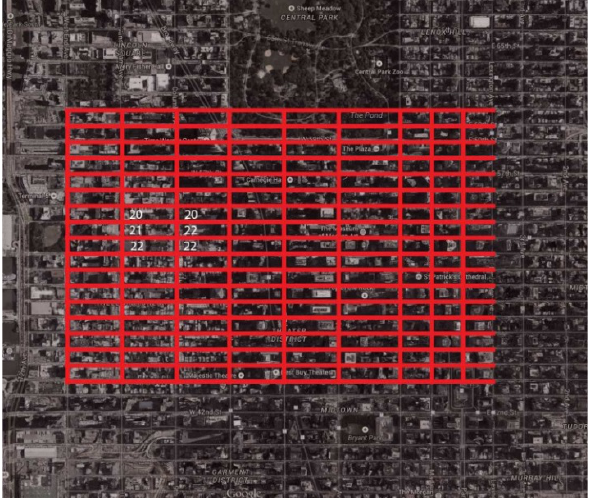
Figure 2. City grid